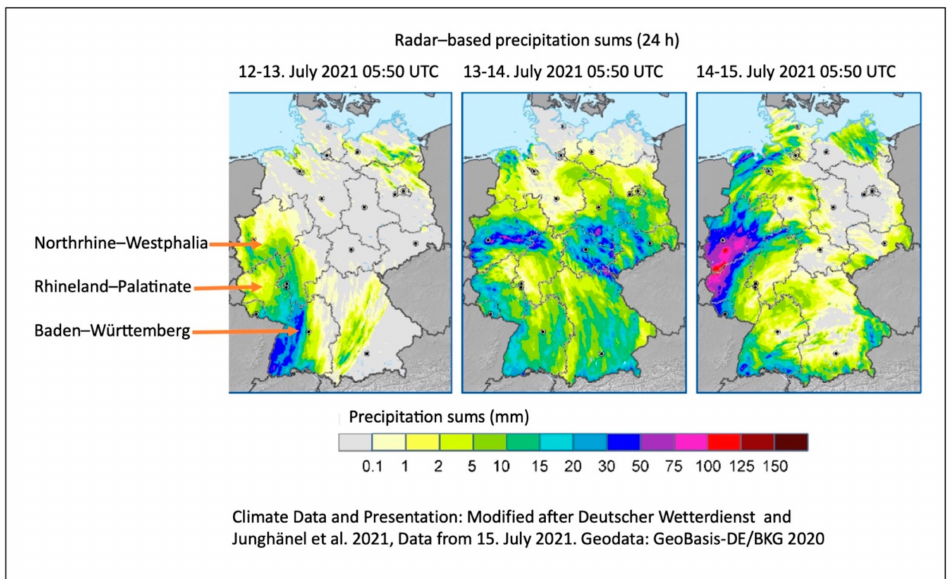
Figure 1. Precipitation data from 12 to 15 July 2021 in Germany, modified from